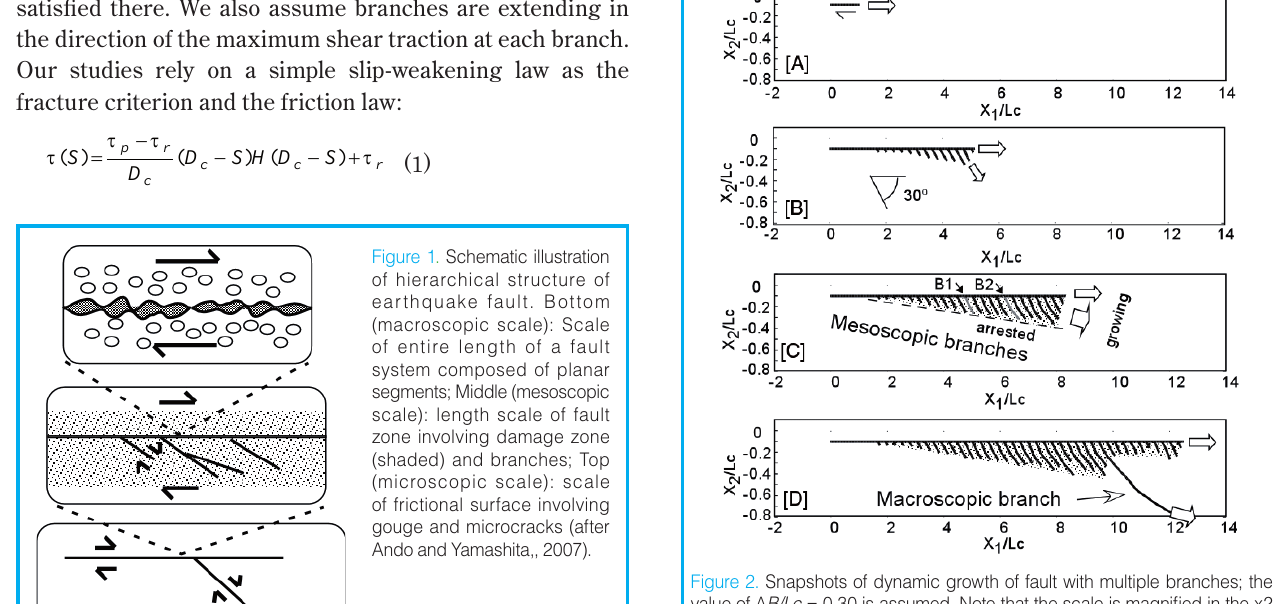
Figure 2. Snapshots of dynamic growth of fault with multiple branches; the value of Δ B/Lc = 0.30 is assumed. Note that the scale is magnified in the x2 direction. (after Ando and Yamashita,